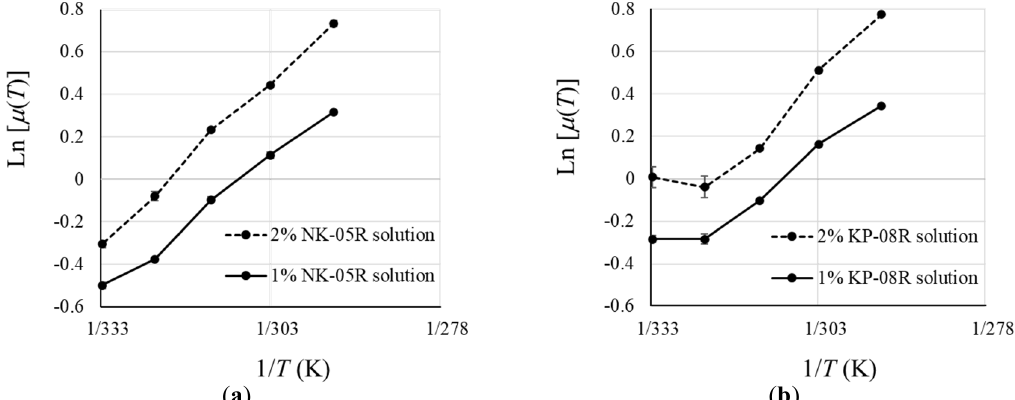
Figure 3. Graphs of the Natural Logarithm of Viscosity Plotted Against the Reciprocal of the Absolute Temperature (1/T): ( a ) NK-05R Solution; ( b ) KP-08R Solution. Each Point Represents the Mean ± SD ( n = 3).